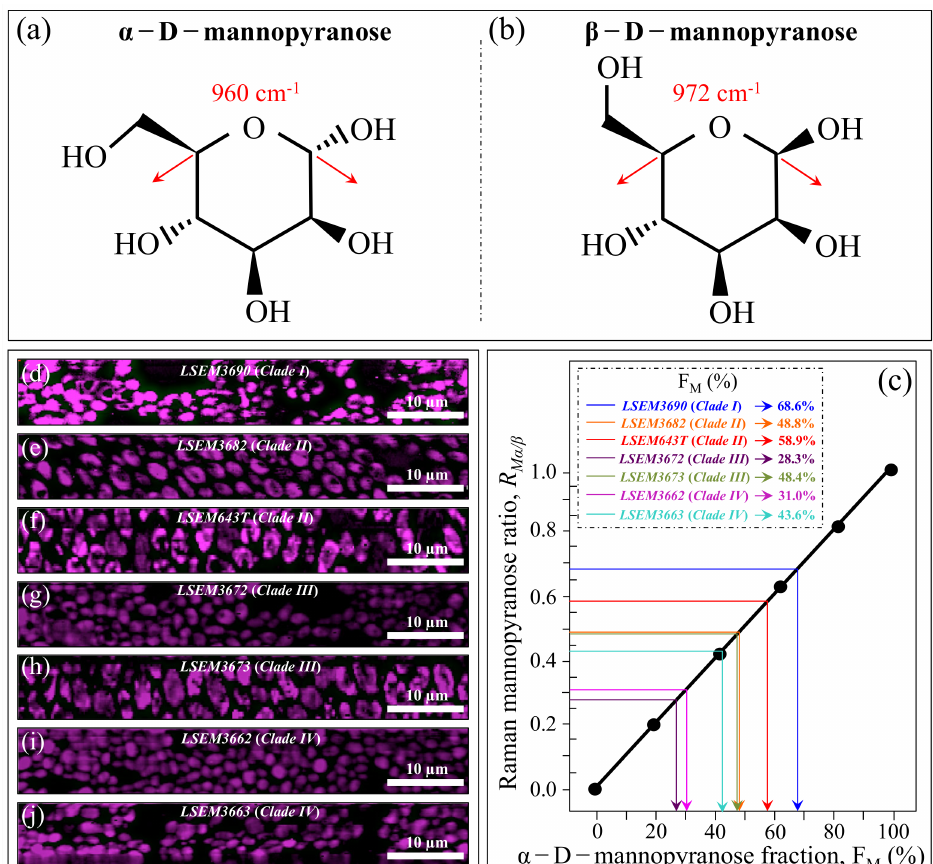
Figure 6. Molecular structure of ( a ) α –D–mannopyranose and ( b ) β –D–mannopyranose (with their respective Raman fingerprint vibrations); ( c ) Raman calibration plot of the R M α / β = I 960 / I 974 + I 960 intensity ratio vs. fractions of α –D–mannopyranose fraction, F M (data from data in Ref. [47]); ( d – j ): Raman images of the R M α / β ratio collected on different C. auris samples (cf. labels). The average R M α / β value for each image locates the respective F M value on the calibration plot ( c ) (cf. values shown in inset given in